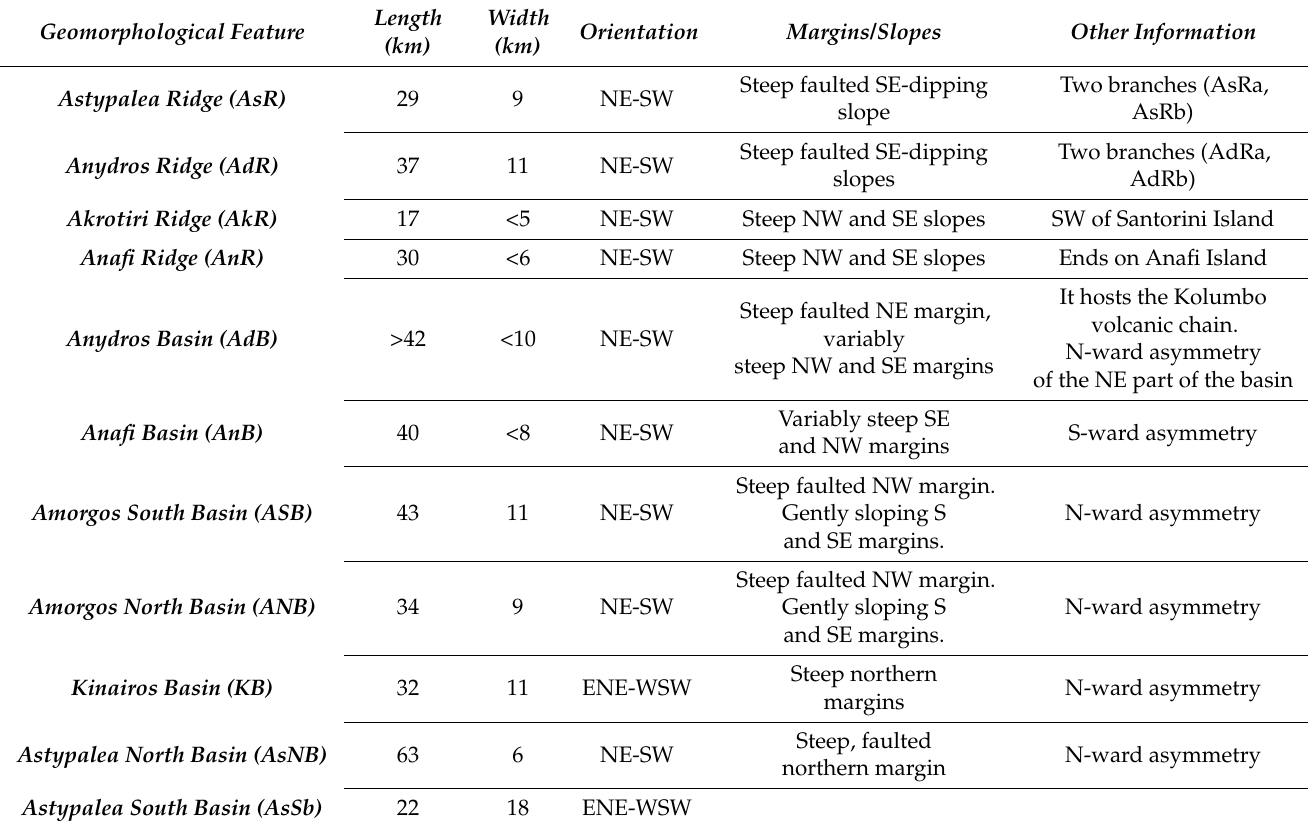
Table 1. Morphological characteristics of SASZ basins and